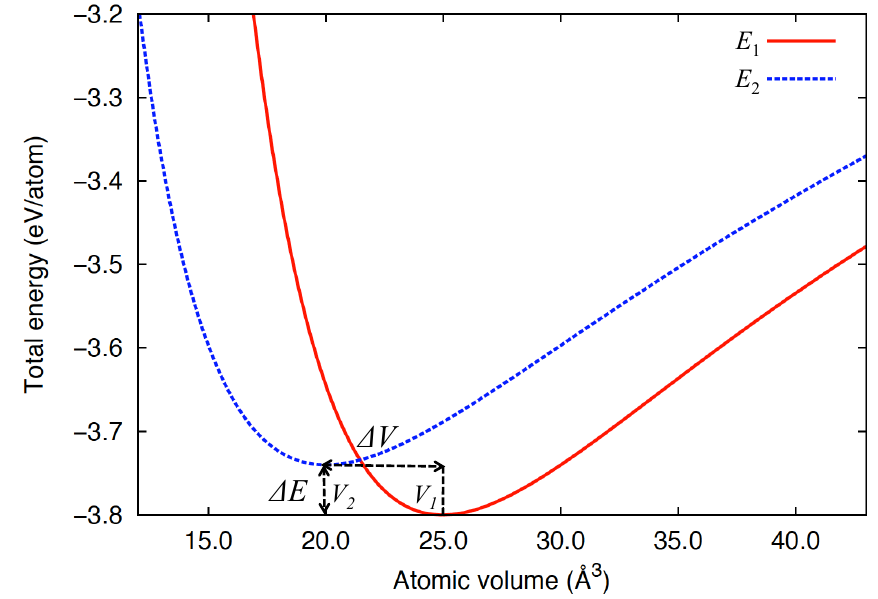
( V ) and E ( V ) for the two competing electronic states Figure 1. Binding energy curves E 1 2 in an effective two-state description of δ -Pu. ∆ V is the difference between the equilibrium ) − E ( V ) ) is the energy separation at equilibrium for volumes V and V , while ∆ E (= E ( V 1 2 2 1 the two